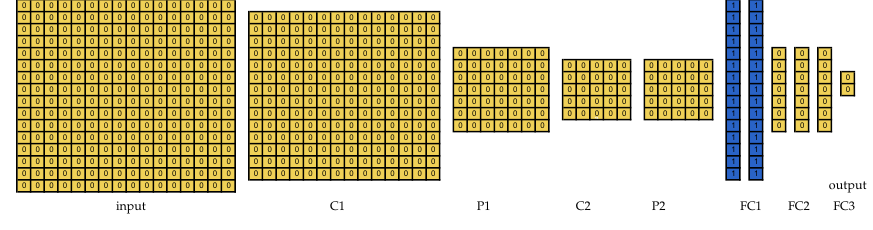
Figure 4. LeNet 2:1 per-layer partitioning provided by the